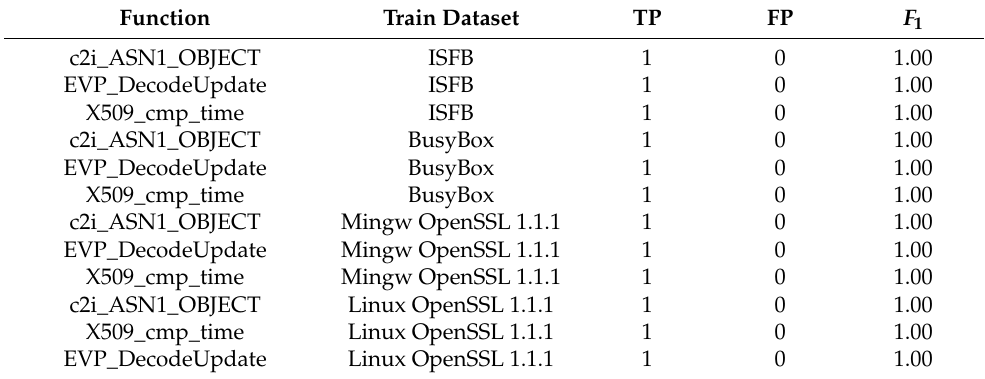
Table 15. Single Function Search